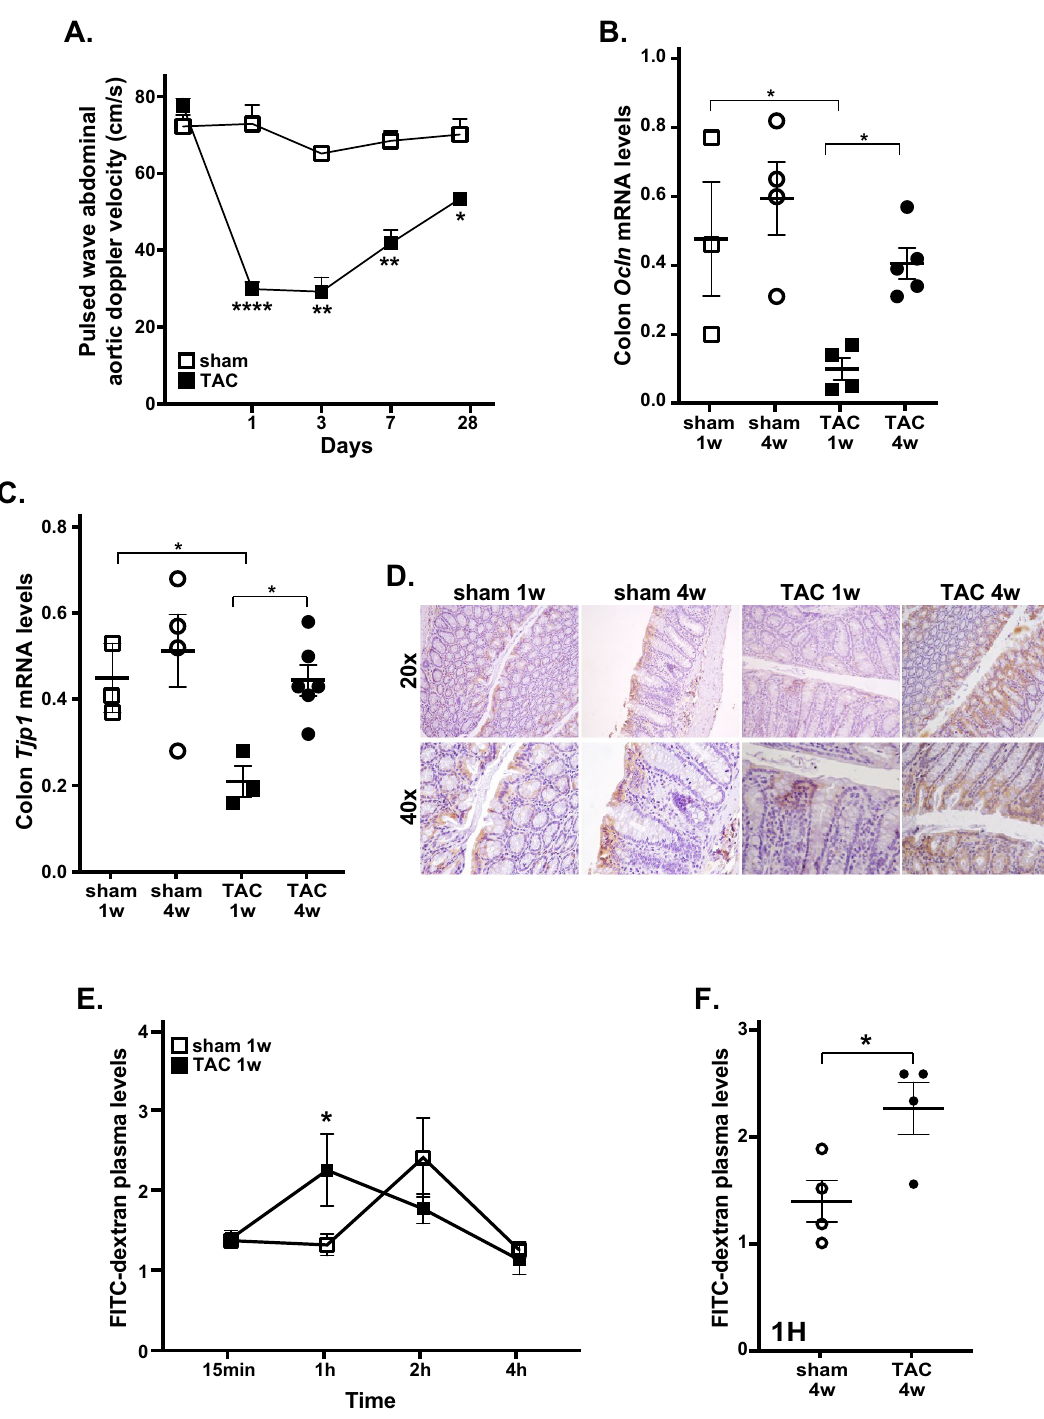
Figure 1. Effects of TAC or sham surgery on intestinal barrier integrity. ( A ) Abdominal aortic blood flow (cm/s) was evaluated at 1, 3, 7 and 28 days after surgical procedure in sham and TAC mice by Pulsed Wave Doppler (sham n = 6; TAC n = 10). ( B , C ) mRNA expression levels of occludin ( Ocln, B ) and tight junction protein ZO-1 ( Tjp1, C ) in colon samples from sham or TAC mice (sham: n = 3–4; TAC: n = 3–6). ( D ) Representative images of immunohistochemical analysis of tight junction protein ZO-1 in colon samples from the different groups of mice (sham 1w: n = 6; sham 4w: n = 5; TAC 1w: n = 4; TAC 4w: n = 6). ZO-1 positive cells were stained in brown; bigger brown and deeper color represent higher ZO-1 protein levels. Pictures are shown at 20 × and 40 × magnification. ( E ) Plasma levels of FITC-dextran 4000 at 15 min, 1, 2, 4 h after gavage in sham 1w and TAC 1w mice (sham 1w: n = 14; TAC 1w: n = 12). ( F ) Plasma levels of FITC-dextran 4000 1 h after gavage in sham 4w and TAC 4w (sham 4w: n = 4; TAC 4w: n = 4). Results are presented as mean ±